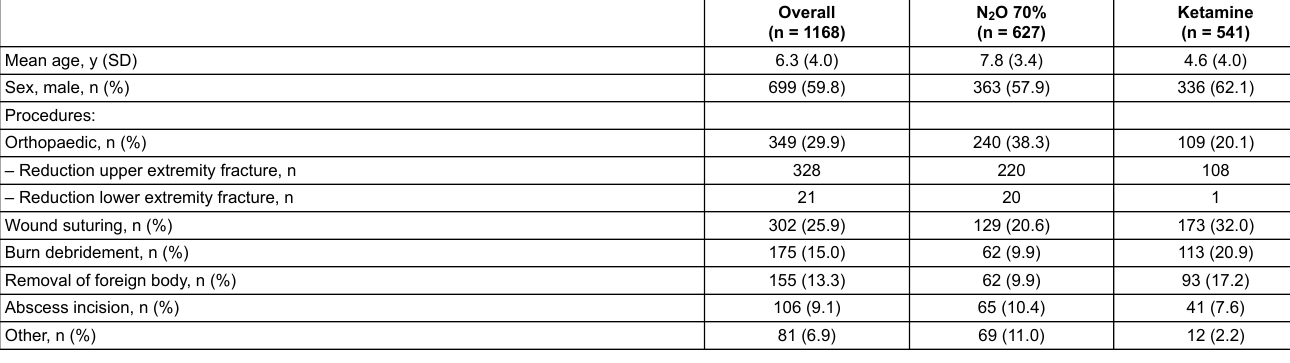
Table 1: Characteristics of patients who received nitrous oxide 70% (N 2 O 70%) or